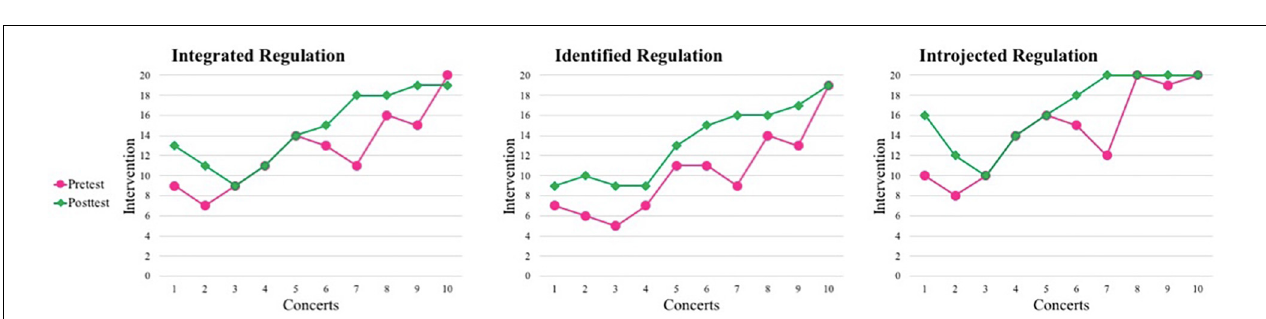
FIGURE 4 | Visual tendency for integrated, identified, and introjected regulation.